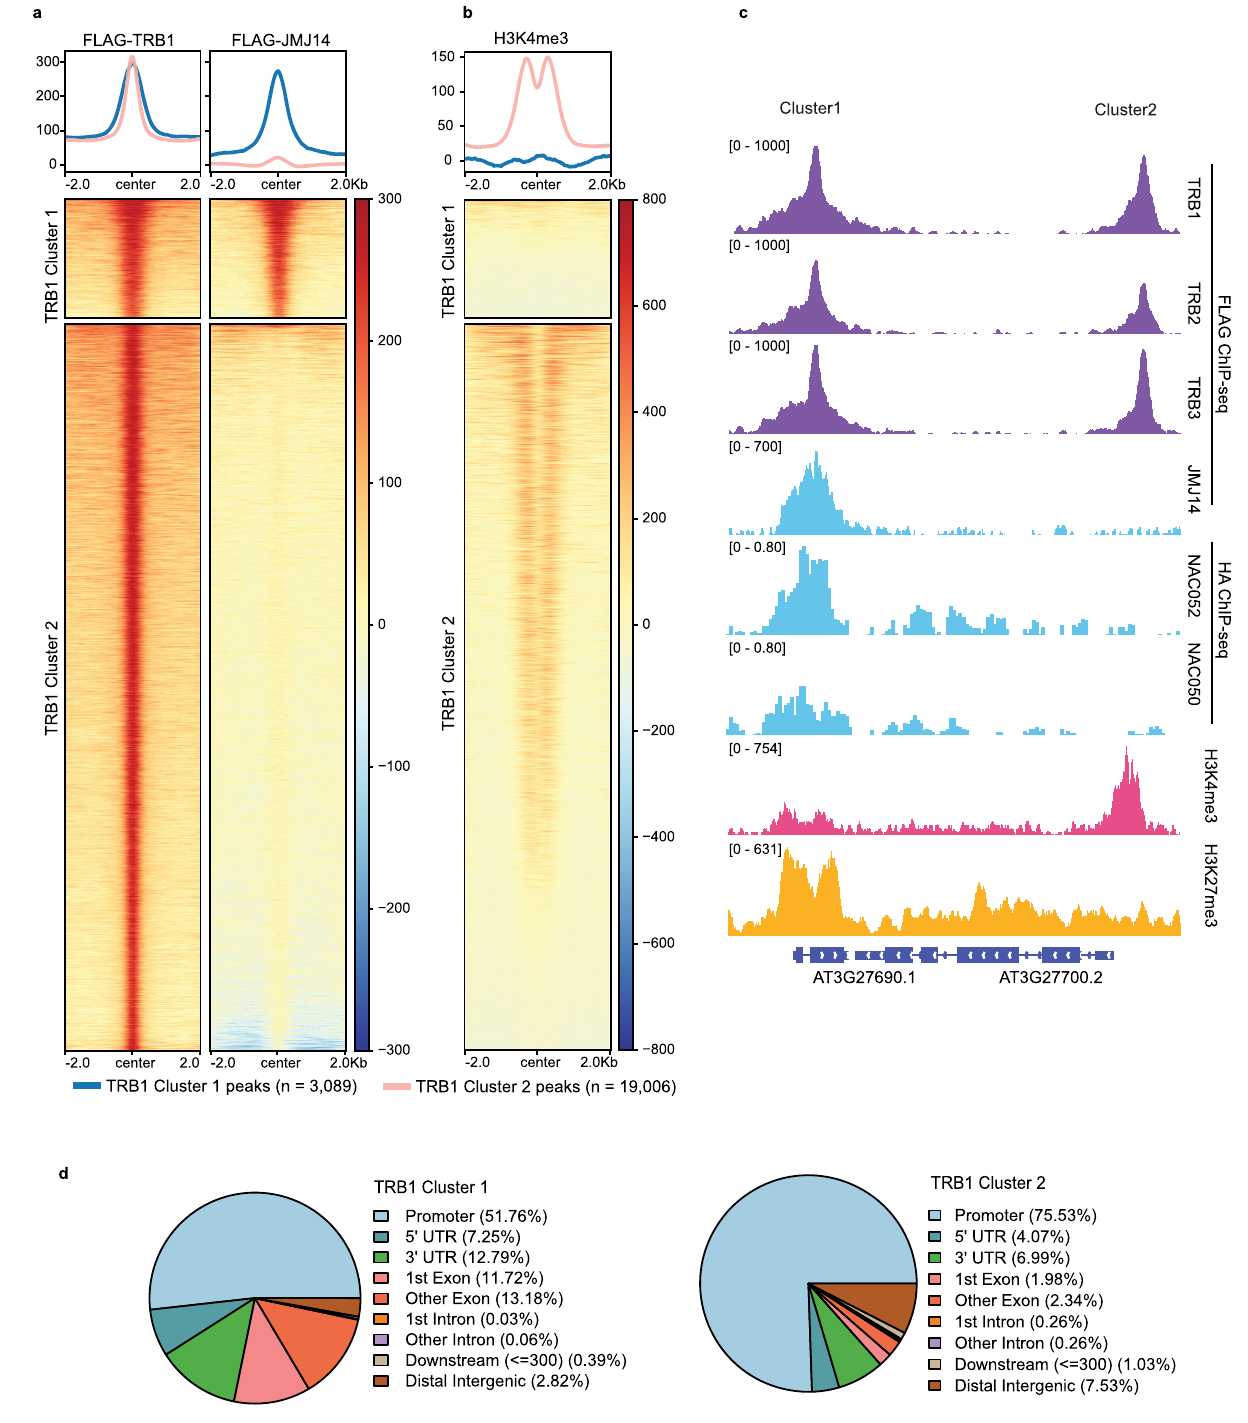
Fig. 2 | TRB1 peaks overlap with JMJ14 peaks at H3K4me3 depleted regions. a , b HeatmapsandmetaplotsshowingChIP-seqsignalsofFLAG-TRB1( a ,leftpanel), FLAG-JMJ14 ( a , right panel),and H3K4me3( b ) over TRB1Cluster 1 peaks ( n =3089) and Cluster 2 peaks ( n =19,006), respectively. c Screenshots displaying the ChIP-